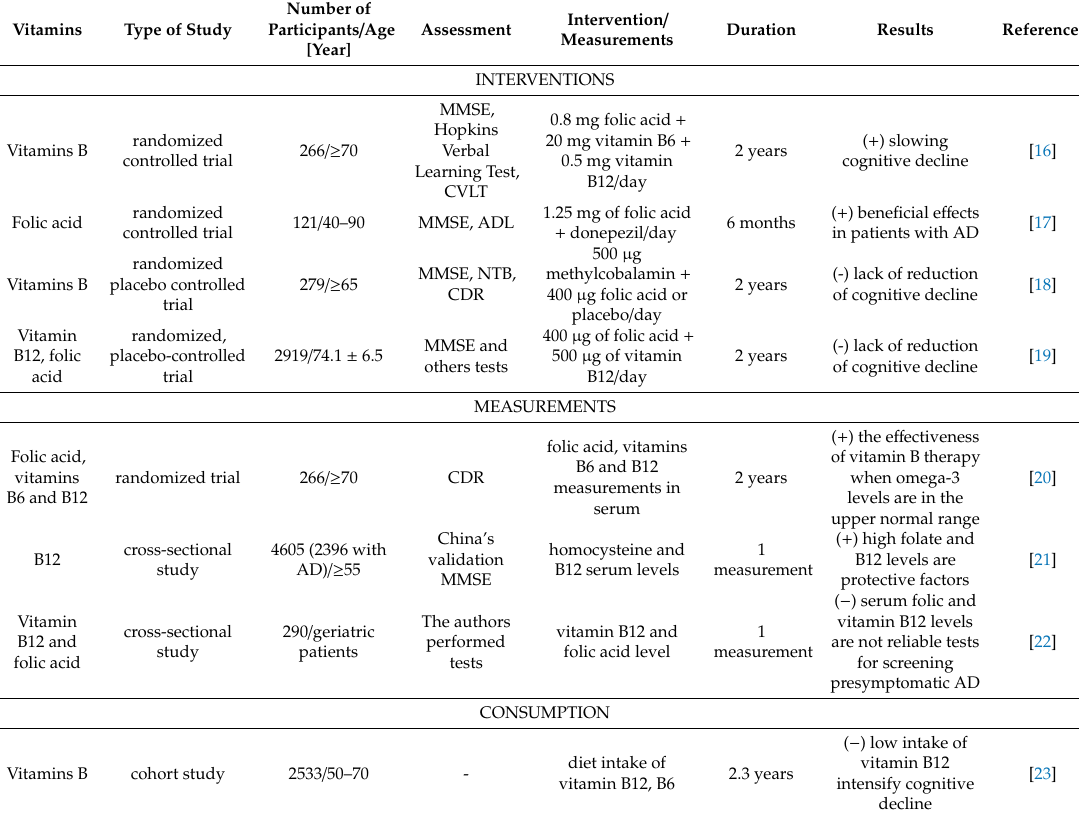
Table 2. Summary of studies on vitamin B intake and measurements in